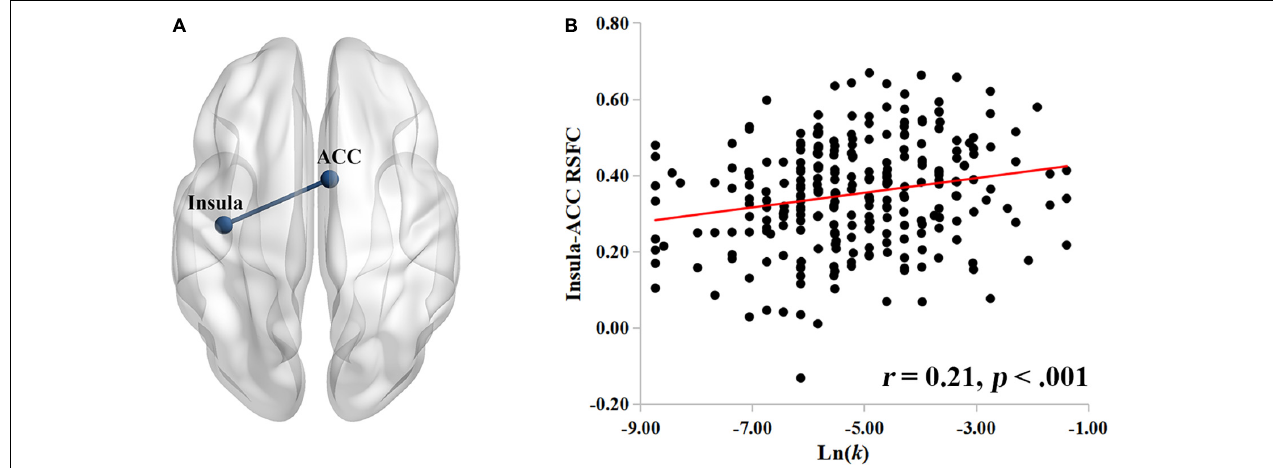
FIGURE 2 | The insula-ACC RSFC is related to delay discounting. (A) The insula-ACC connectivity significantly correlated with the Ln( k ) values. (B) The scatter plot showing the positive correlation between the insula-ACC RSFC and the Ln( k ) values. Nodes and edges in the networks are overlaid on inflated surface maps generated by BrainNet Viewer (Xia et al.,